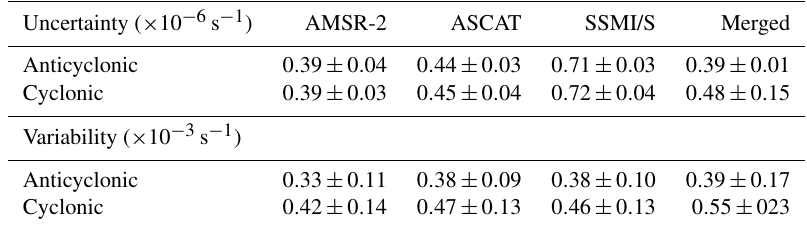
Table 1. The mean and standard deviation of the uncertainty and variability of vorticity of all features detected between 2017–2020 (format: mean ± SD). Note the relative scale of units of the uncertainty estimates relative to that of the